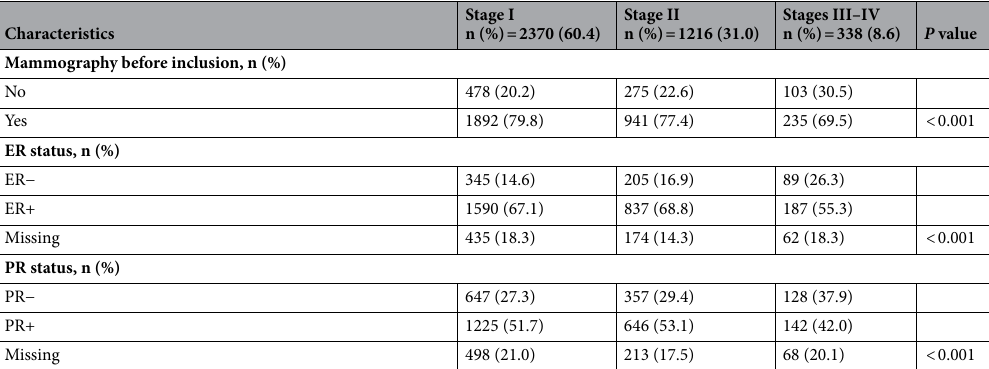
Table 1. Demographic and lifestyle characteristics of cases according to the stage of breast cancer at diagnosis in the case–control study nested within the E3N cohort, France, 1990–2008. The analyses were done on the three stages after excluding cases with missing stage information (477 cases). P values were estimated based on Kruskal–Wallis test for continuous variables and Chi-square test for categorical variables. SD